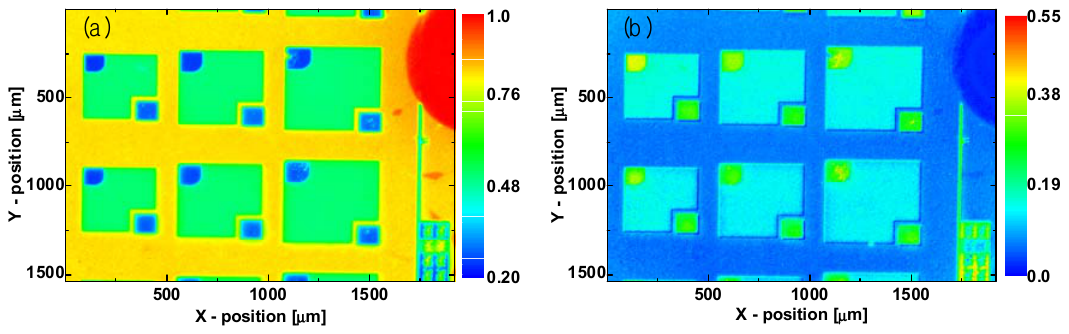
/ I ) image of LED r s